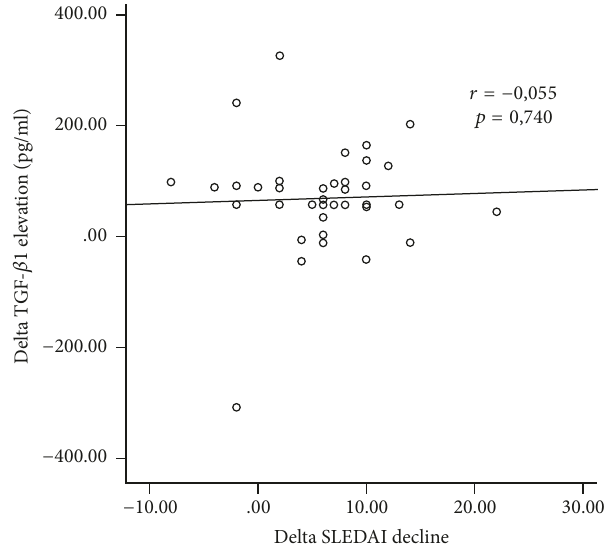
Figure 4: Correlation between SLEDAI and elevation of TGF- 𝛽 1 serum after